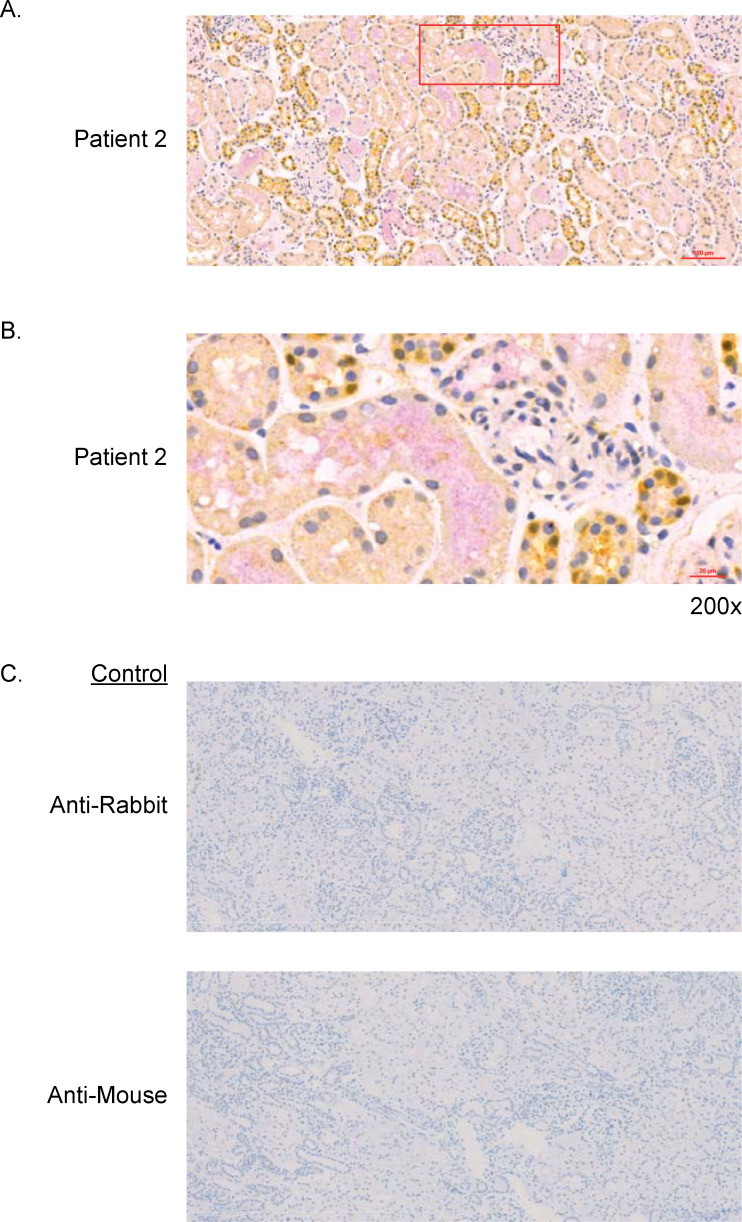
Dual immunohistochemical detection.(A) Co-distribution of GSK1070806 (pink) with IL18 (yellow) in wedge biopsies from Patient 2. Nuclei stained with hematoxylin. (B) 200x magnified region of Patient 2 biopsy, taken from the area outlined in A, showing the luminal co-distribution of GSK1070806 (pink) and IL18 (yellow) in the tubules. (C) Isotype control staining. IL18, interleukin-18.